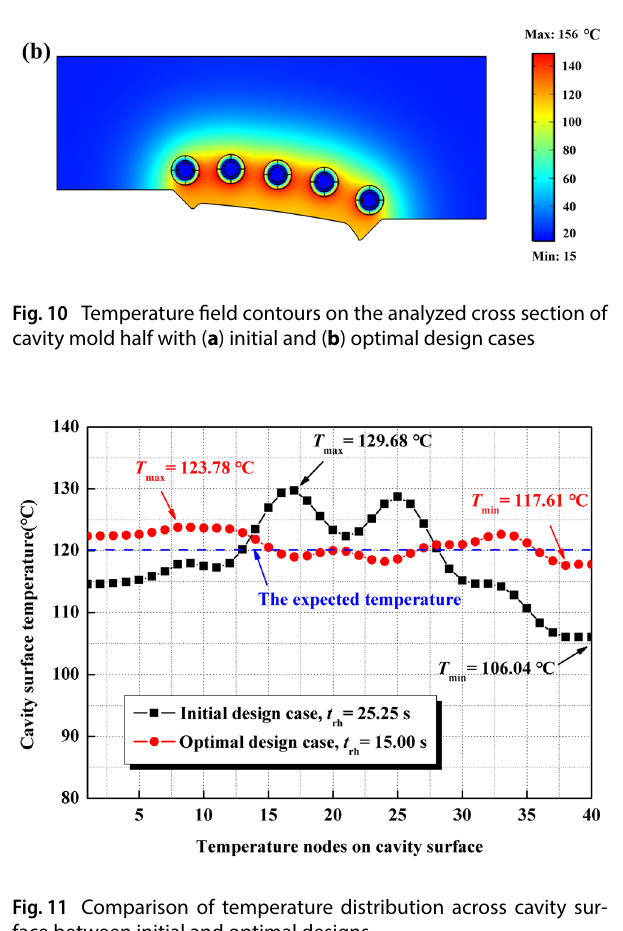
Fig. 11 Comparison of temperature distribution across cavity sur- face between initial and optimal